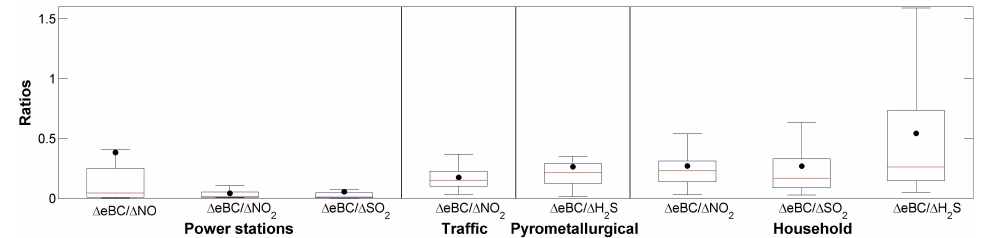
Figure 15. Ratio of (cid:49) eBC divided by (cid:49) of other species relevant to the identification of each source type, except for grassland and savannah fires measured at Elandsfontein.